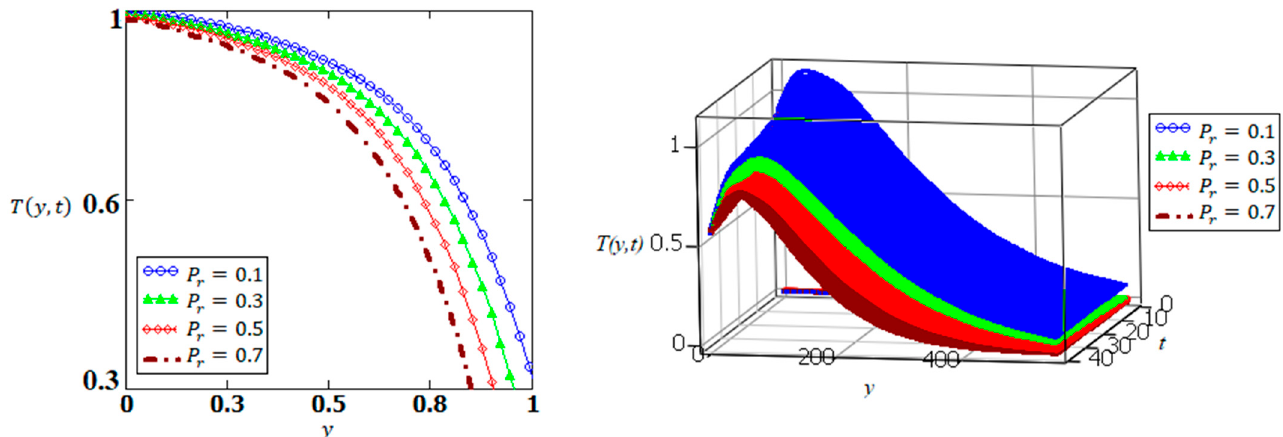
Figure 2. Effective role of temperature distribution depicted from Equation (12) for P r